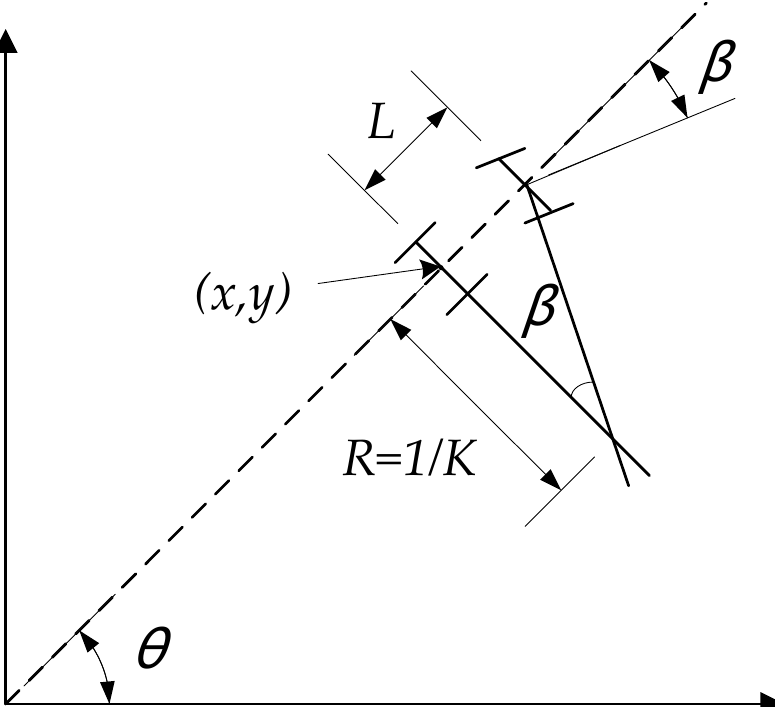
Figure 3. The vehicle kinematic model.